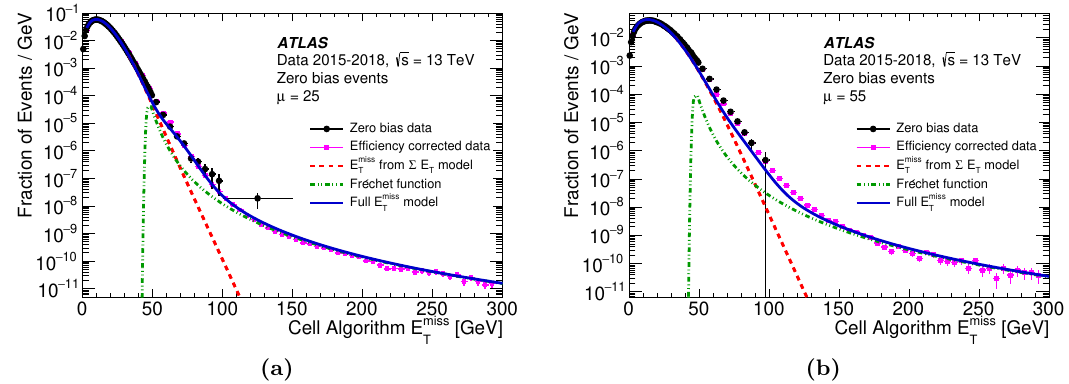
Figure 1. A comparison of the measured cell E miss distribution with that predicted by the T two-component model for two pile-up scenarios compared with data. The circular points show the data collected using zero bias triggers, but have insu(cid:14)cient luminosity to probe the higher E miss portion of the distribution. The square points extend the measured distribution using L1 T E miss > 30 GeV and L1 E miss > 50 GeV data. The uncertainties for the data points are statistical T T only, and much larger for the zero bias data due to the limited luminosity. The dashed (red) curve is the prediction from the calorimeter-resolution part of the model. The dash-dotted (green) curve is the high E miss tail’s probability distribution for the mean number of pp interactions (cid:22) in each T (cid:12)gure. The solid (blue) curve is the full model prediction computed by combining the E miss from T these two individual sources shown in red and green, each calculated for (cid:22) = h (cid:22) i . The black points show the unbiased E miss distribution measured in data. (a) corresponds to a prediction for h (cid:22) i = 25 T while (b) corresponds to h (cid:22) i =